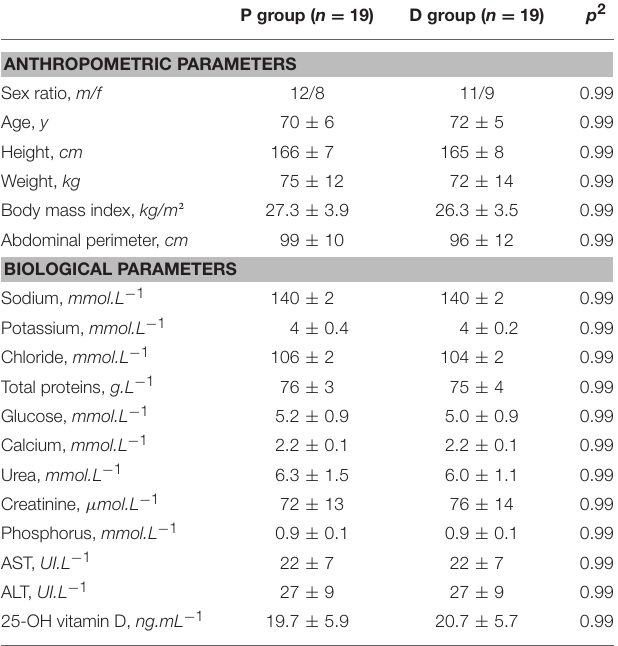
TABLE 1 | Characteristics of healthy volunteers at inclusion 1 .